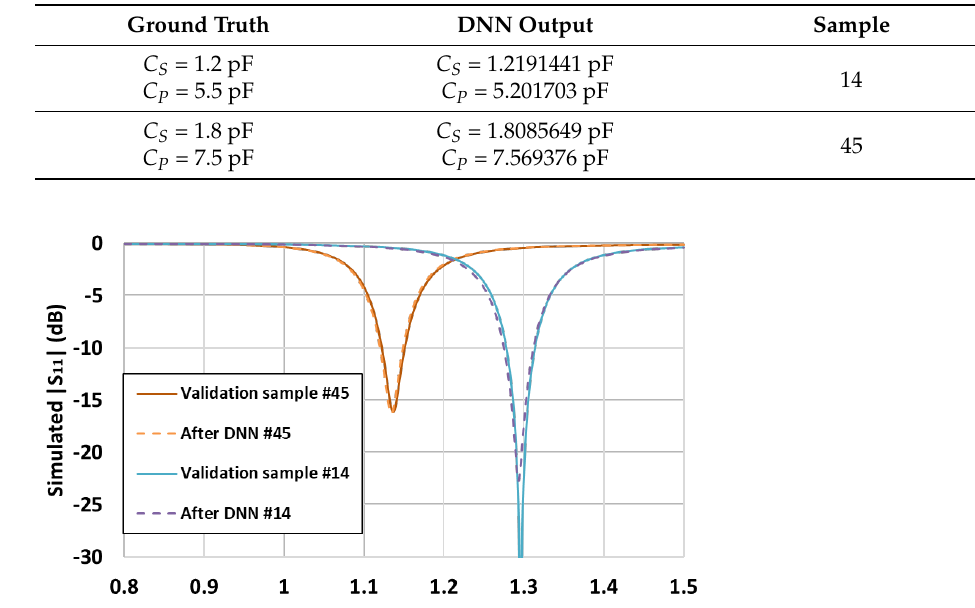
Table 3. Capacitor values in matching circuit for validation.